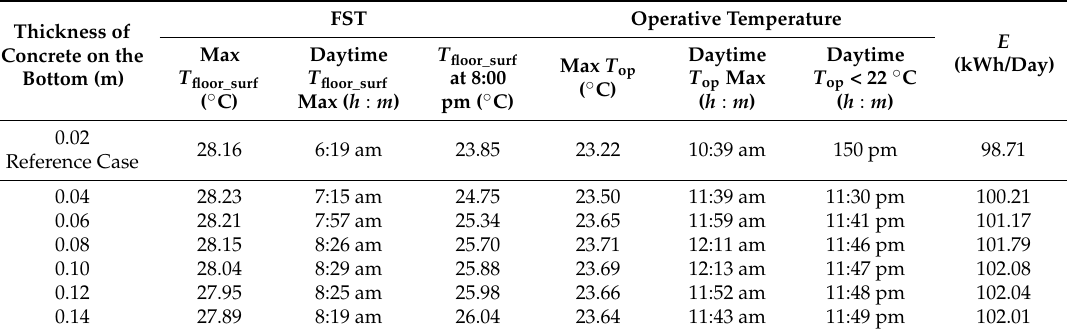
Table 5. Results of the parametric study: Impact of the lower layer concrete thickness.